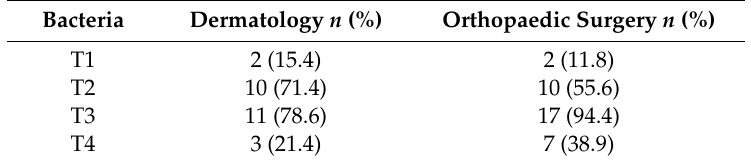
Table 2. Contamination rates with both resistant and sensitive bacterial strains at the different sampling times (T1 to T4) for the medical units of dermatology ( n = 14) and orthopaedic surgery ( n = 18). Bacteria Dermatology n (%) Orthopaedic Surgery n (%) T1